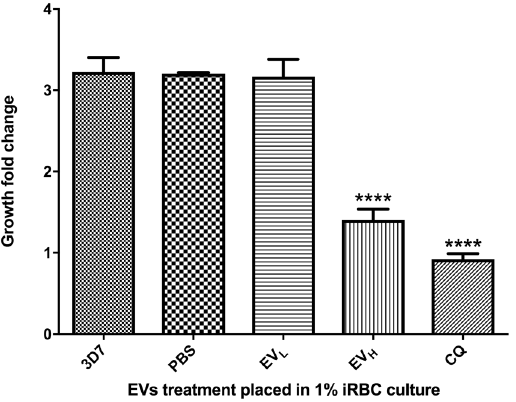
Figure 2. Growth inhibition of P . falciparum by EVs. The growth of parasites after distinct EV treatments was measured by flow cytometry. The average and S.D. of 3 replicas for each treatment is shown. (mean ± s.e.m.; n = 3 replicas), **** P < 0.0001 versus PBS and 3D7 growth control (Bonferroni’s test). Chloroquine 25 was used as a drug control.